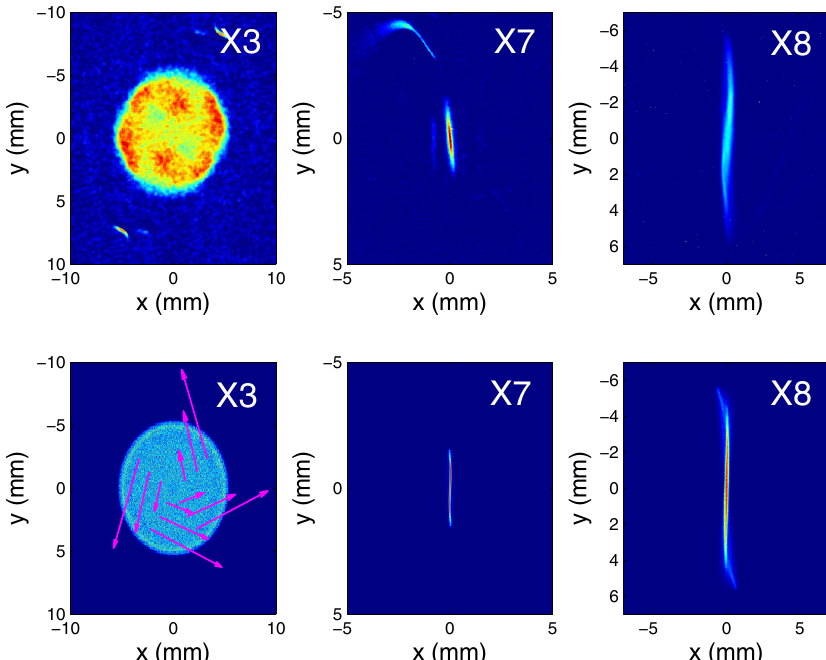
FIG. 3. (Color) Example of the transformation of the incoming angular-momentum-dominated round beam (measured at X3 viewer) into a flat beam. The beam transverse distribution is highly asymmetric and remains upright on viewers X7 and X8. Top row: measurements; bottom row: corresponding numerical simulations. The arrows on bottom left plot indicate the directions of momentum computed for a subset of macroparticles. The momentum at X7 and X8 is mainly directed along the y axis (not shown for clarity). [The (cid:6) 0 : 97 mm (see text for data presented in this figure correspond to the case of (cid:2) c